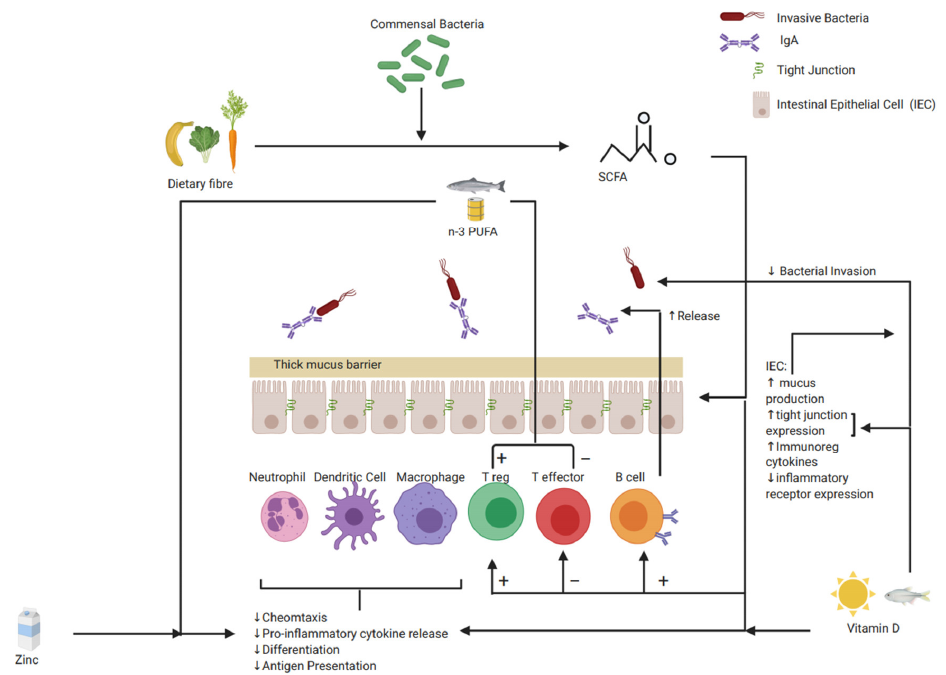
Figure 1. Schematic representation of proposed mechanism of favourable diet–gut immune interaction that may protect from the development of IBD and improve disease activity (Created with BioRender). Abbreviations: polyunsaturated fatty acid (PUFA), short-chain fatty acid (SCFA), and immunoglobulin (Ig).